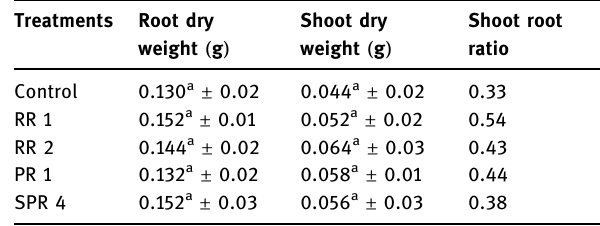
Table 4: E ff ect of PSB on root length of maize seedling Treatments